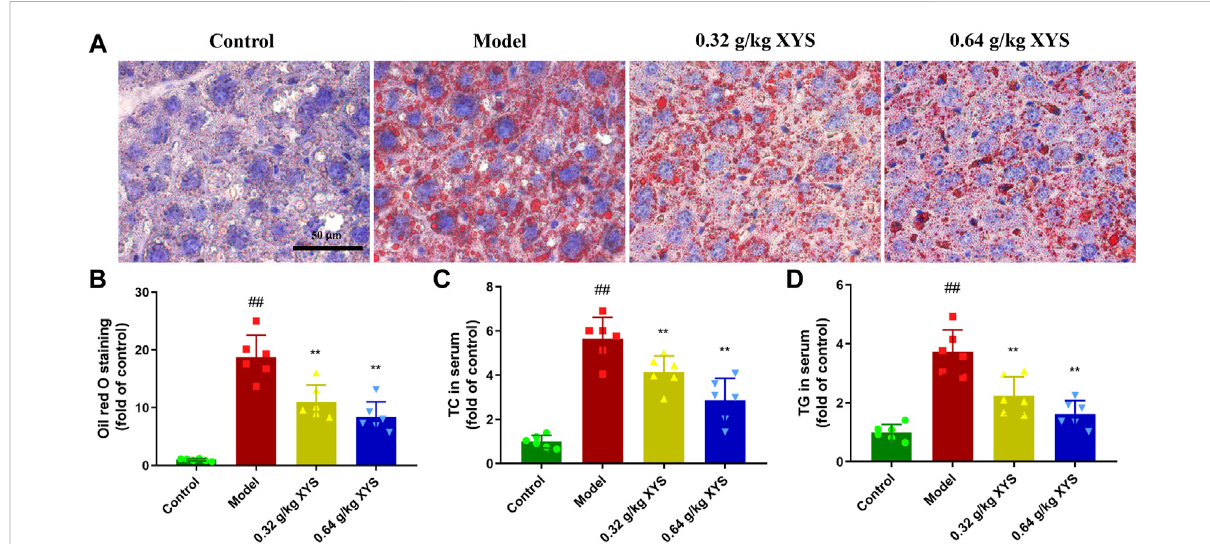
FIGURE 3 OilredOstainingofliverandlipidbiochemicalindicatorsinserumwiththeadministrationofXYS.MiceweretreatedwithXYS(0.32or0.64 g/kg) via gavage for three consecutive days and sacri fi ced on the fourth day. (A) Oil red O staining of mouse liver 24 h after the last administration in each group to detect fat in liver tissues, with red areas representing fat droplets. (B) Relative content of oil red O staining in mouse liver tissues in each group, and each bar represents the mean content of oil red in serum ± SD. (C) The level of TC in mouse serum in each group, and each bar represents the mean level of TC in serum ± SD. (D) The TG content in mouse serum in each group. Each bar represents the mean TG content in the serum ± SD. # p < 0.05 vs. Control group, and ## p < 0.01 vs. Control group; p p < 0.05 vs. Model group and pp p < 0.01 vs. Model